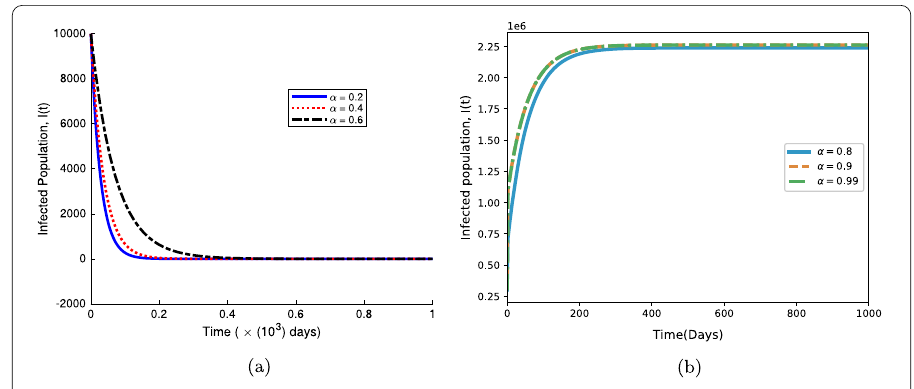
Figure 6 The influence of different values of α on the total density of jigger infested individuals. For ( a ), α = 0.2,0.4,0.6 with R E = 0.7671, whereas α = 0.80,0.90,0.99 for ( b ) with R E = 1.2783. Other parameter values are as displayed in Table